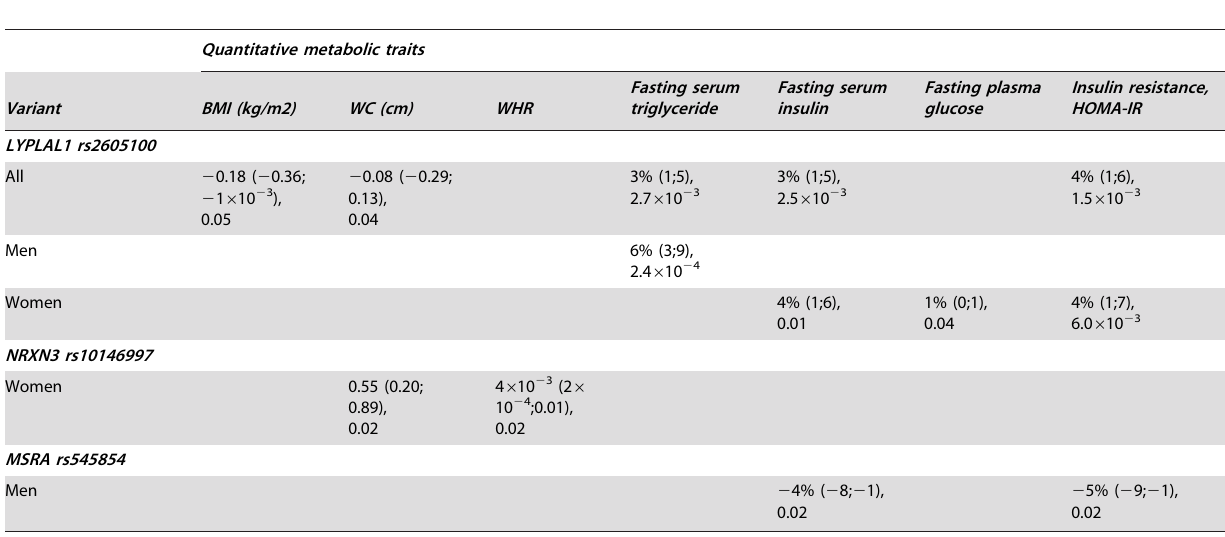
Table 1. Variants showing statistical significant associations with quantitative metabolic traits ( n =6,038).